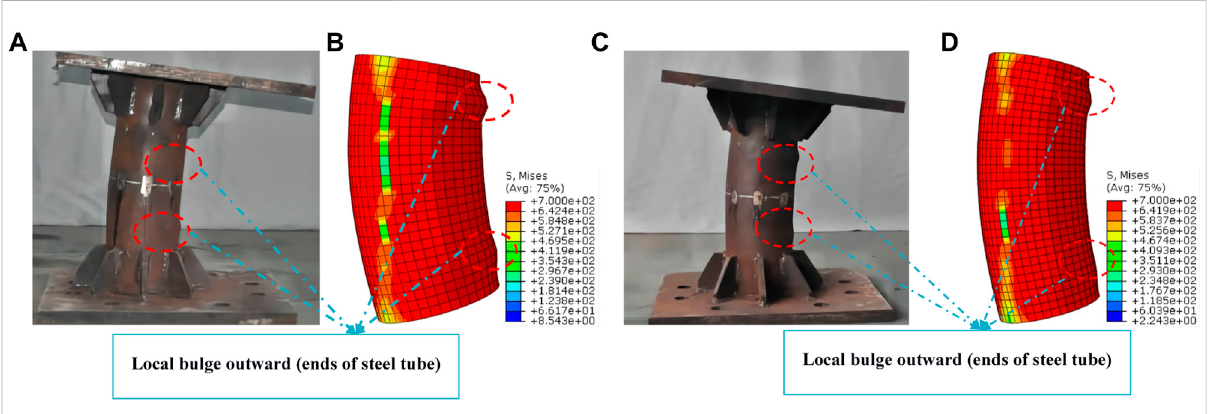
FIGURE 13 Comparisonofsimulatedandexperimentalfailuremodes (A) ThefailuremodeoftestspecimensfromreferenceLuoetal.(2021); (B) Thefailure mode of HCHST-19; (C) The failure mode of test specimens from reference Luo et al. (2021); (D) The failure mode of HCHST-20.